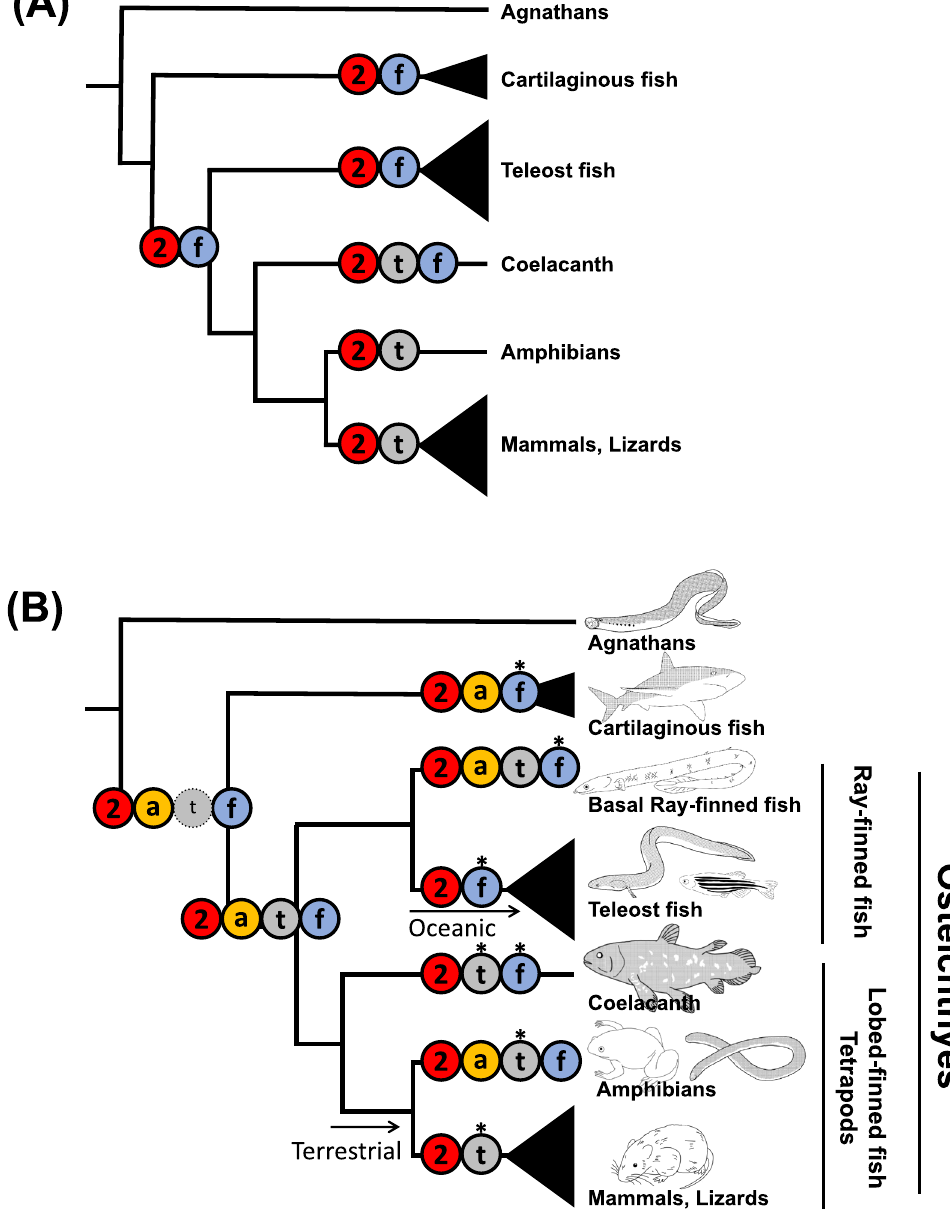
Figure 4. Evolutionary scenarios of V2R s during vertebrate evolution proposed by previous ( A ) and this ( B ) studies. The presence/absence of the four major V2R clades was plotted on the phylogenetic tree of vertebrates from agnathans to mammals. The red circle with “2,” yellow with “a,” gray with “t,” and blue with “f” indicate V2R2 , ancV2R , t- V2R s, and f- V2R s, respectively. ( A ) Except for V2R2 , teleost fish and tetrapods possess only f- V2R s or t- V2R s, respectively, while the coelacanth possesses both V2R s. Common ancestor of Osteichthyes was expected to possess V2R2 and f- V2R s. ( B ) The large-scale analyses revealed the existence of t- V2R s in basal ray-finned fish and identified a novel clade of ancV2R . In contrast to basal ray-finned fish with all four clades of V2R s, teleost fish, mammals, and lizards possess only two of them. The reduction of specific V2R clades in these lineages would be due to adaptation to specific oceanic and terrestrial environments. Note that the origin of t- V2R s dates back to the common ancestor of extant Osteichthyes, but its antiquity in the jawed vertebrate ancestor remains to be examined with complete genome sequences of more cartilaginous fish (dotted circle with “t” inside). Asterisks above the circles indicate clades with substantial copy numbers due to gene expansions in each extant species. The illustration of the animals was drawn by using free software Vectr (https:// vectr.